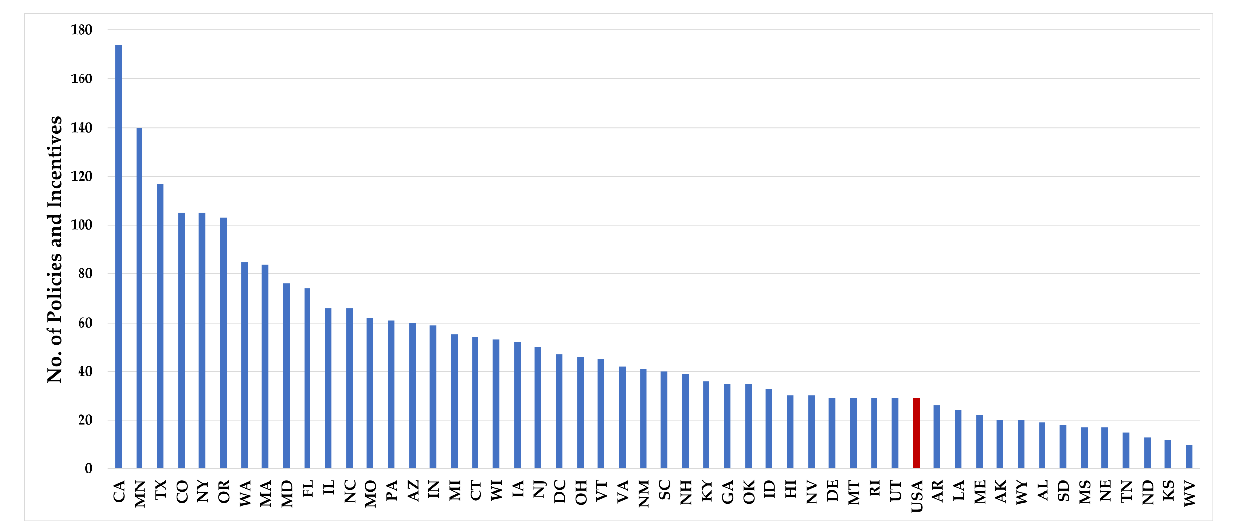
Figure 2. Number of policies and incentives by US state. The enacted policies vary by state, with California having the highest number of policies (176) and West Virginia having the lowest number of policies (10). The federal government, highlighted in red, is ranked 39 with 29 policies (data source: [45]).